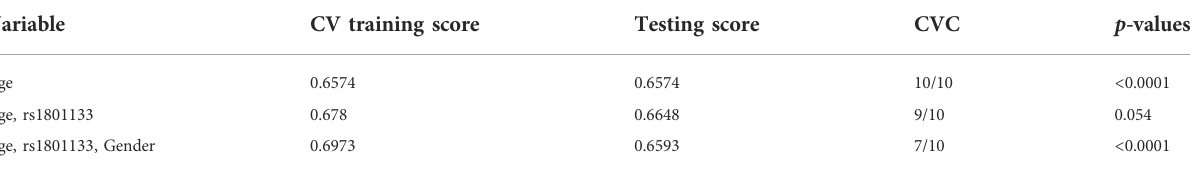
TABLE 4 Interaction models between genetic and sociodemographic factors.